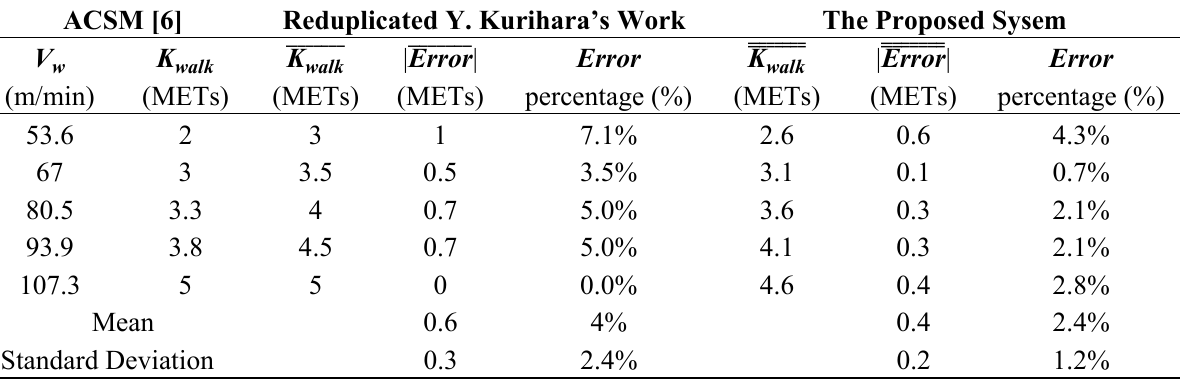
Table 4. Comparison of accuracy of corresponding formulas in ACSM, reduplicated Y. Kurihara’s work, and our proposed